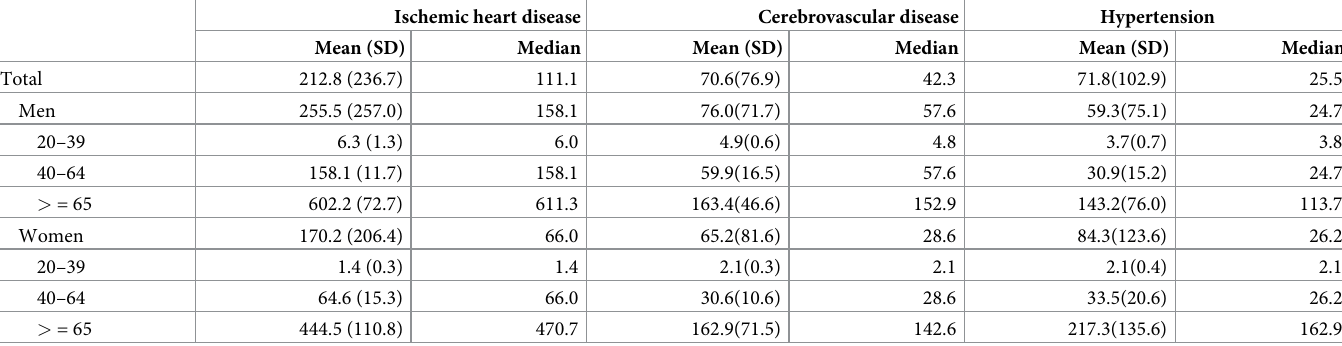
Table 2. Quarterly incidence rates of hospitalization due to cardiovascular diseases (per 100,000 persons) in Taiwan,